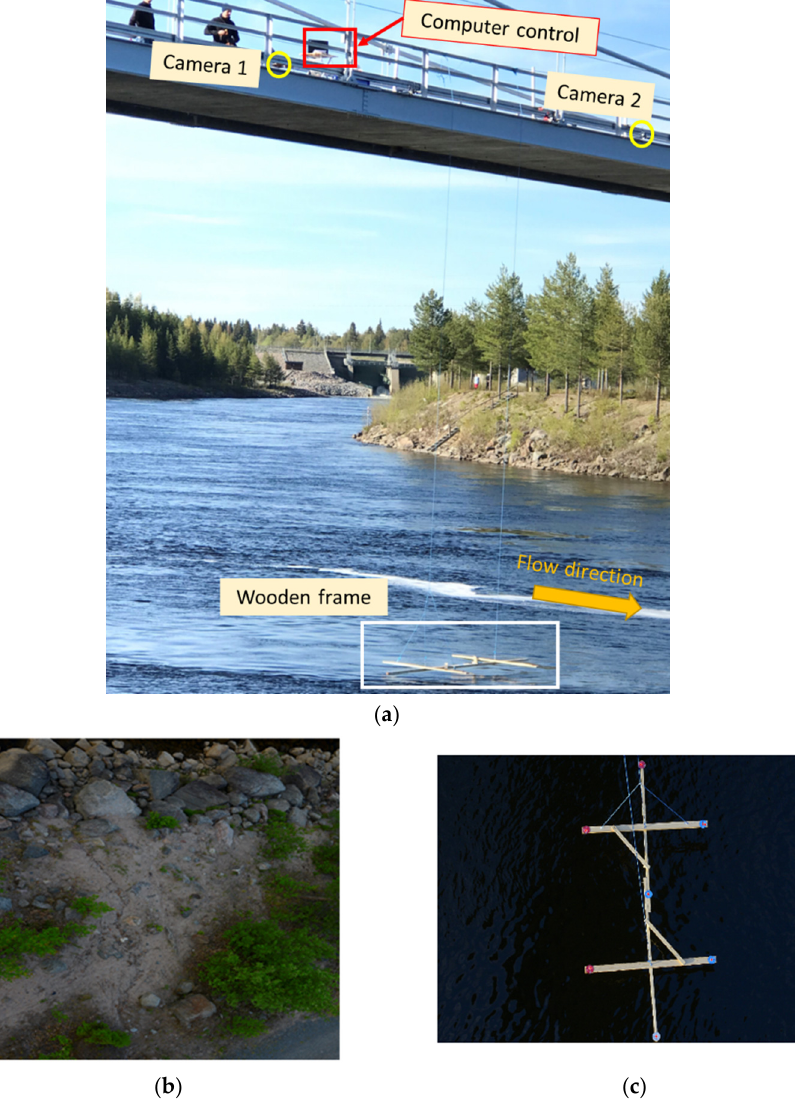
Figure 3. Field measurements setup and camera calibration: ( a ) River flow measurement setup; ( b ) Natural pattern for intrinsic camera calibration (Agisoft Metashape); ( c ) Reference wooden frame for extrinsic camera calibration.